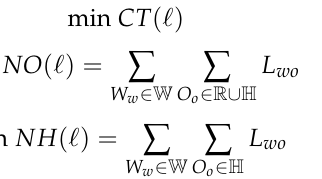
Table 1. The indices used in the model.